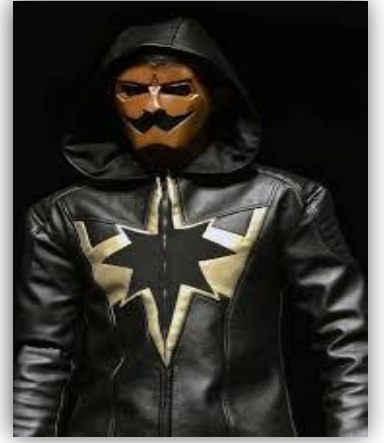
Figure 10. Initial Concept of Gatotkaca by R.A Kosasih